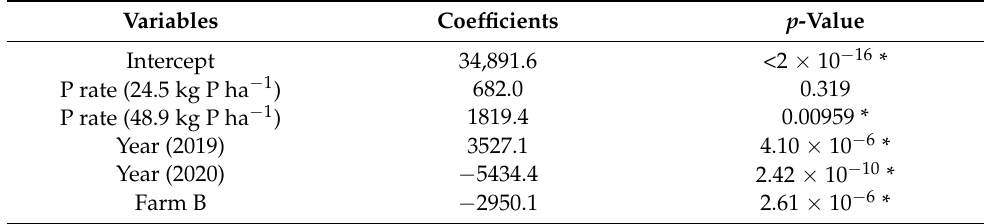
Table 5. Regression of yield on the P rate, year of the measure, and